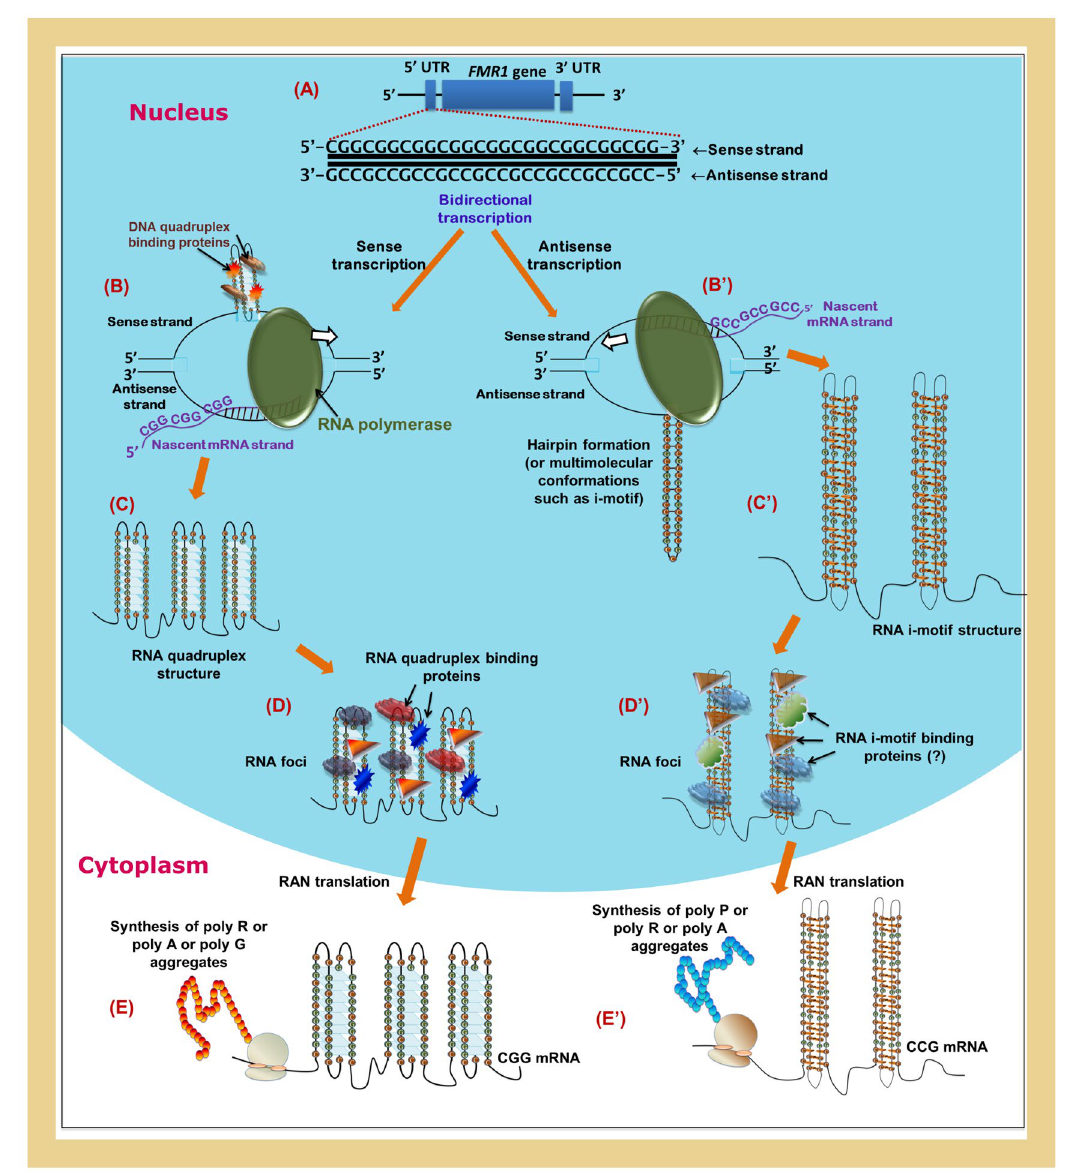
Figure 6. Proposed mechanism for the pathogenesis of FXTAS. ( A ) Expansion of CGG/CCG repeats in the 5 ′ UTR facilitates quadruplex (sense strand) and hairpin (antisense strand) formation. ( B ) Extended stability for the R-loop facilitates ( C ) quadruplex formation in FMR1 CGG mRNA due to the stalling of RNA polymerase. ( D ) RNA quadruplex-binding proteins facilitate RNA foci formation and ( E ) promote RAN translation to synthesize poly R or poly A or poly G aggregates. ( B ′ – E ′ ) RNA misprocessing and RAN translation associated with CCG antisense FMR1 mRNA. CCG repeats in RNA translate to either poly P or poly R or poly A aggregates. This figure was generated using Inkscape 0.91(https:// inksc ape. org/)